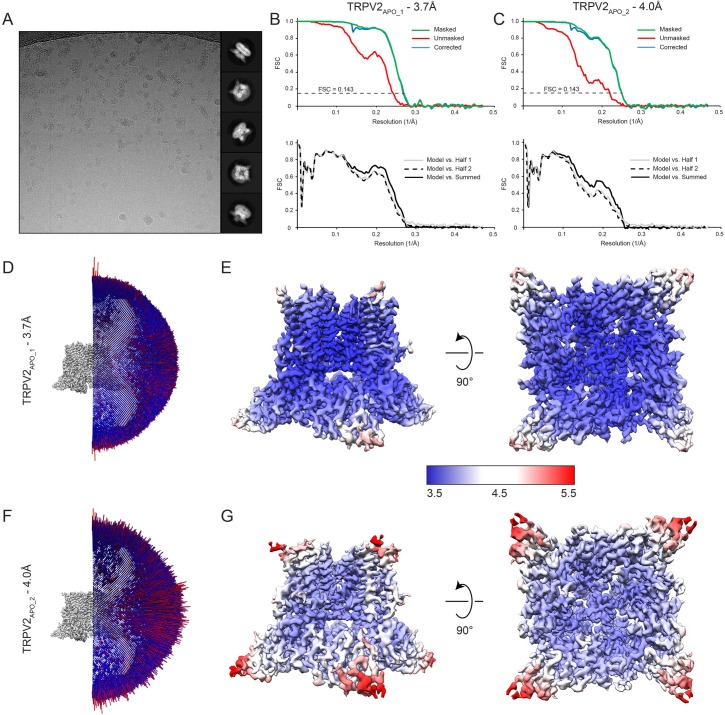
EM summary of apo full-length rat TRPV2 in nanodiscs.(A) Representative micrograph and 2D classes of cryo-EM data. Map FSC curves and model validation curves for (B) TRPV2APO_1 and (C) TRPV2APO_2. Angular distribution for the final 3D reconstruction of (D) TRPV2APO_1 and (F) TRPV2APO_2. Tall red cylinders indicate a large number of particles aligned at a position and short blue cylinders indicate fewer particles. (D) Side and bottom views of (E) TRPV2APO_1 and (G) TRPV2APO_2 colored based on local resolution as calculated via RELION. Blue, white and red regions indicate resolutions of 3.5 Å, 4.5 Å and 5.5 Å, respectively.